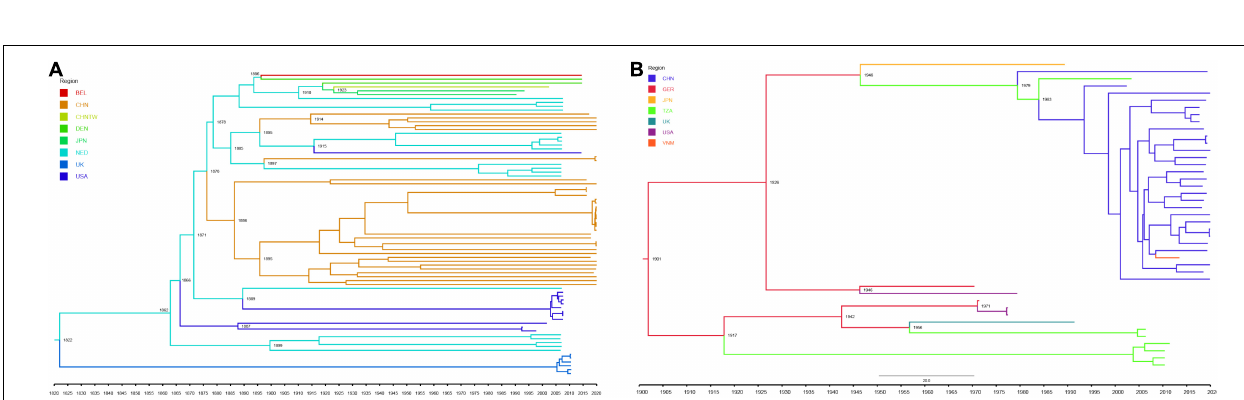
Frontiers in Microbiology |